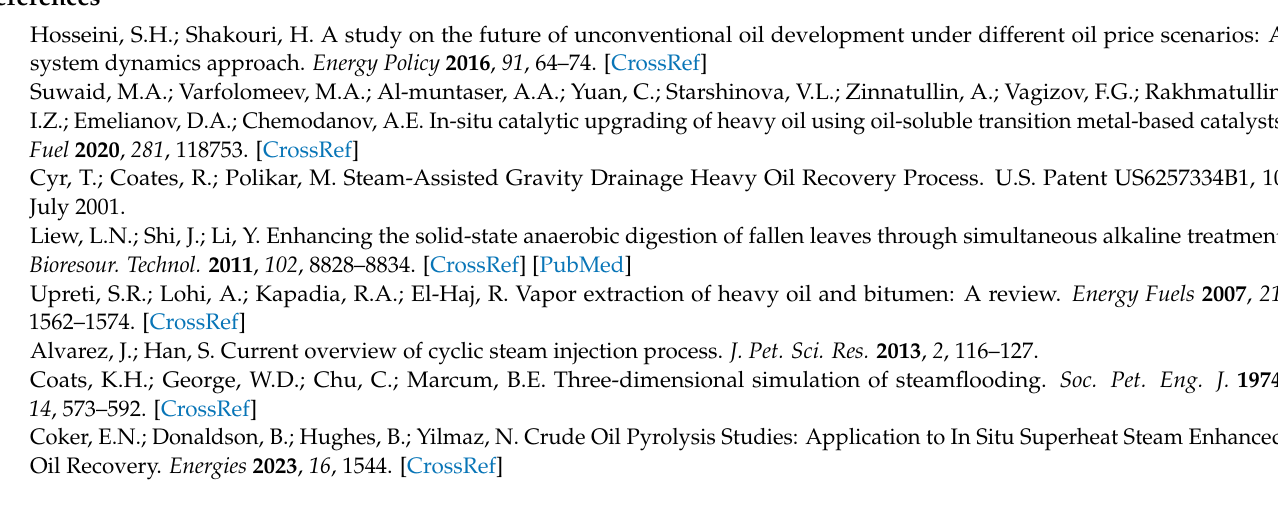
Figure S3: Isotherm of adsorption and desorption of catalyst-3; Figure S4: Chromatogram of saturate fractions of heavy crude oil; Figure S5: Chromatogram of saturate fractions of upgraded oil +steam; Figure S6: Chromatogram of saturate fractions of upgraded oil + catalyst-1; Figure S7: Chromatogram of saturate fractions of upgraded oil + catalyst-2; Figure S8: Chromatogram of saturate fractions of upgraded oil +